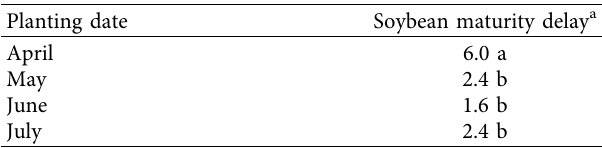
Table 5: Days delay until soybean maturity relative to the non- treated check averaged over a low-dose dicamba exposure at V 3, R 1, and V 3 followed by R 1 stage of soybean.